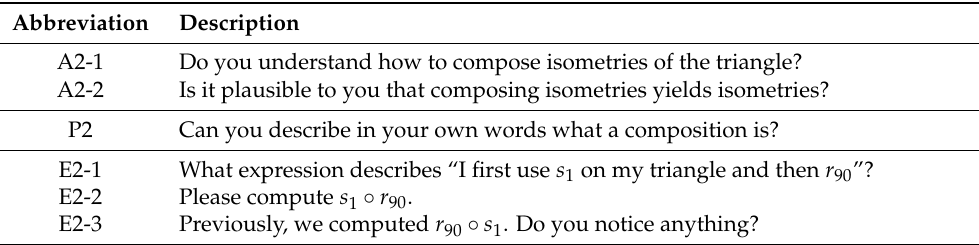
Table A2. Overview and descriptions for all units included in the interview regarding key idea 2 ( Composition of isometries , cf. Table 1). A stands for acceptance, P for paraphrasing, and E for exercise.